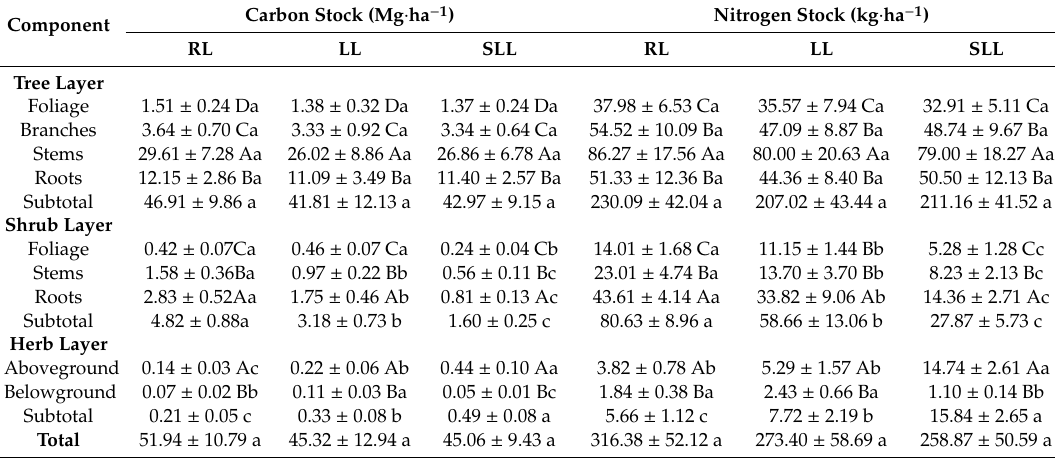
Table 4. Carbon and nitrogen stocks in the vegetation layer.